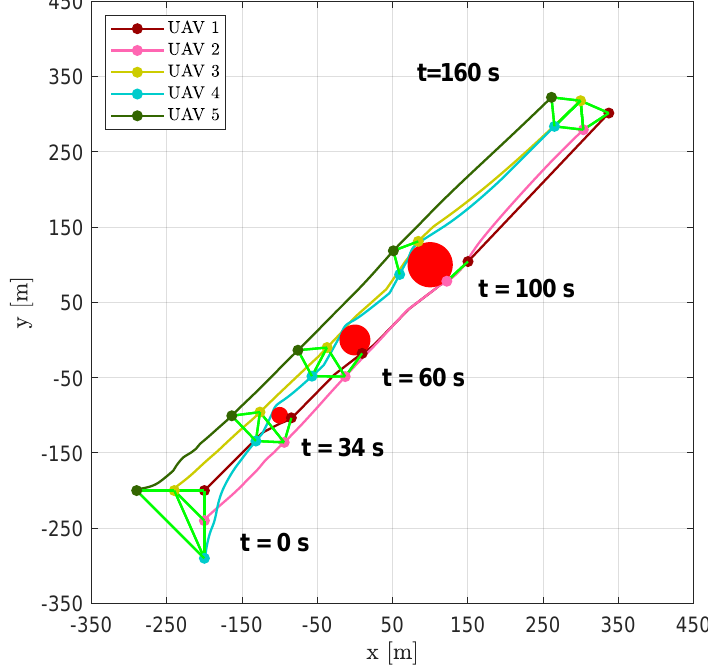
Figure 11. Scenario #1—five aircraft: UAVs trajectories. Red circles represent obstacles; colored markers indicate positions at different time instants; green straight lines highlight DTG